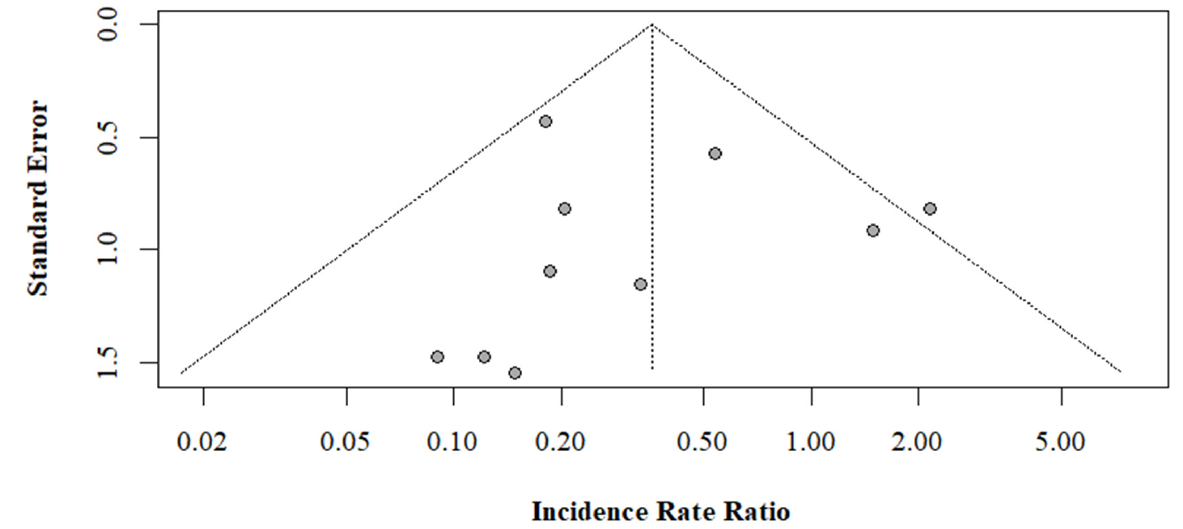
Figure 5. Funnel plot for the random-effect estimate.